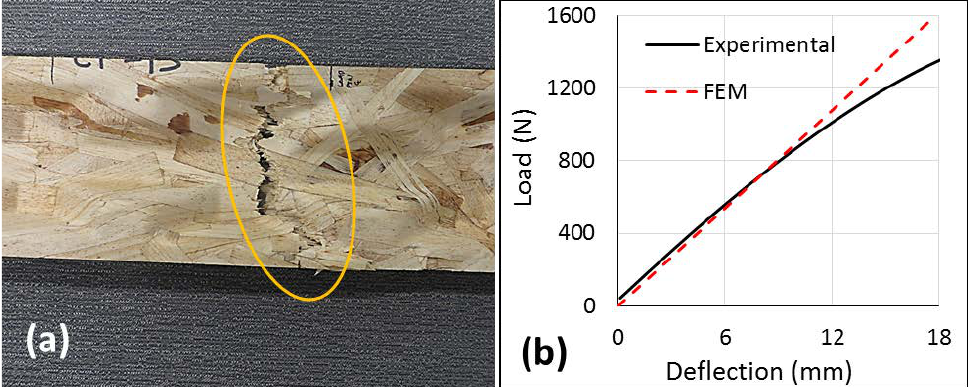
Figure 8. Four-point bending test of the 3-D core layer in the longitudinal ( a ) failure mode ( b ) load–deflection curve.